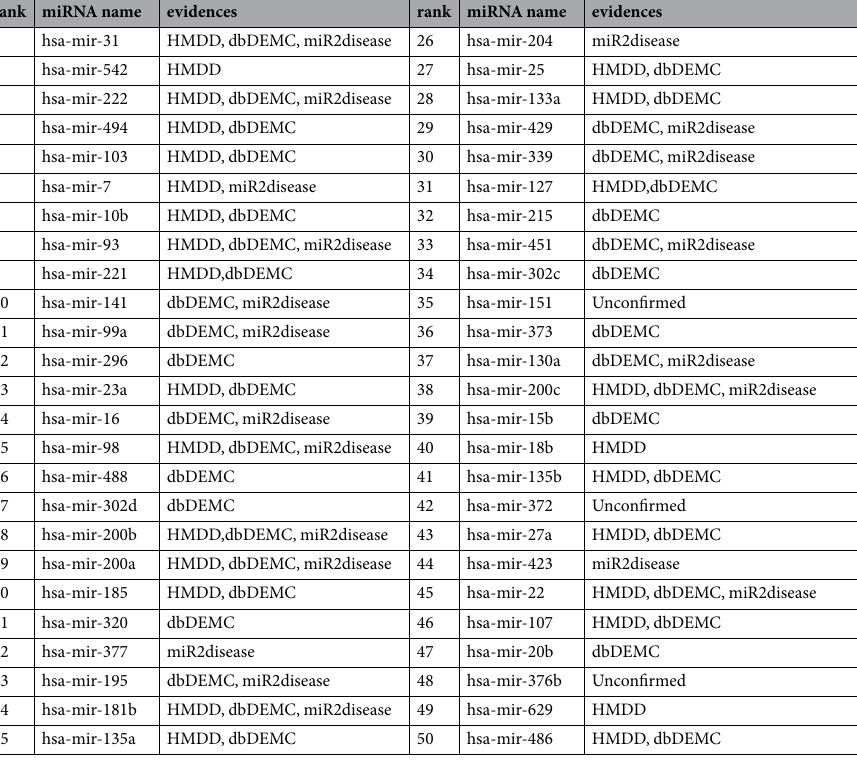
Table 2. The top 50 lung cancer-related miRNAs predicted by ILRMR and the confirmation of these associations. Forty-seven of the top 50 potential lung cancer miRNAs candidates have been confirmed based on the update HMDD, dbDEMC and